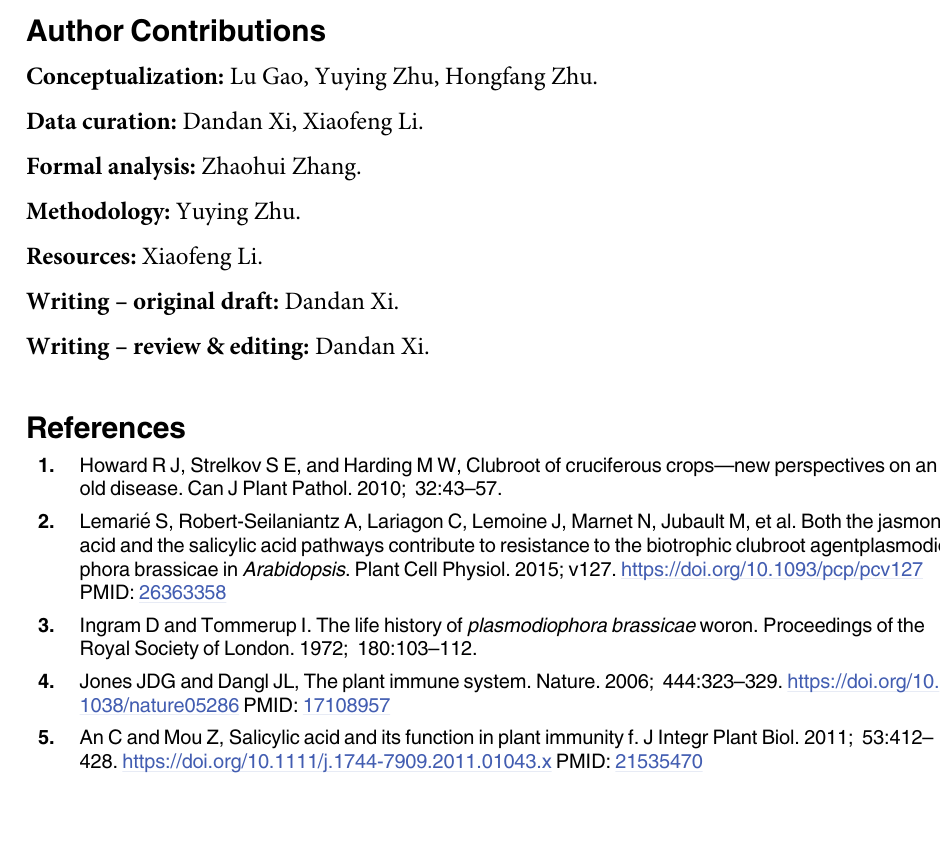
S1 Table. Primers used for